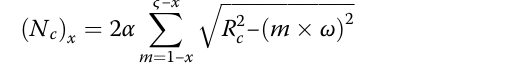
ffiffiffiffiffiffiffiffiffiffiffiffiffiffiffiffiffiffiffiffiffiffiffiffiffiffiffi